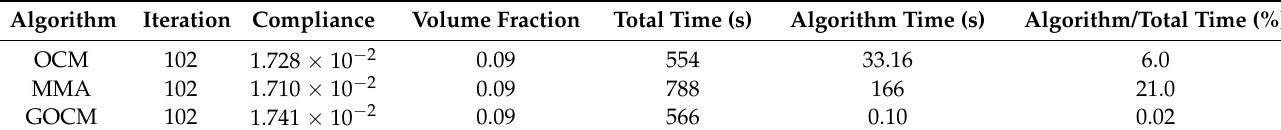
Table 3. Comparison of optimum designs using different optimization algorithms.